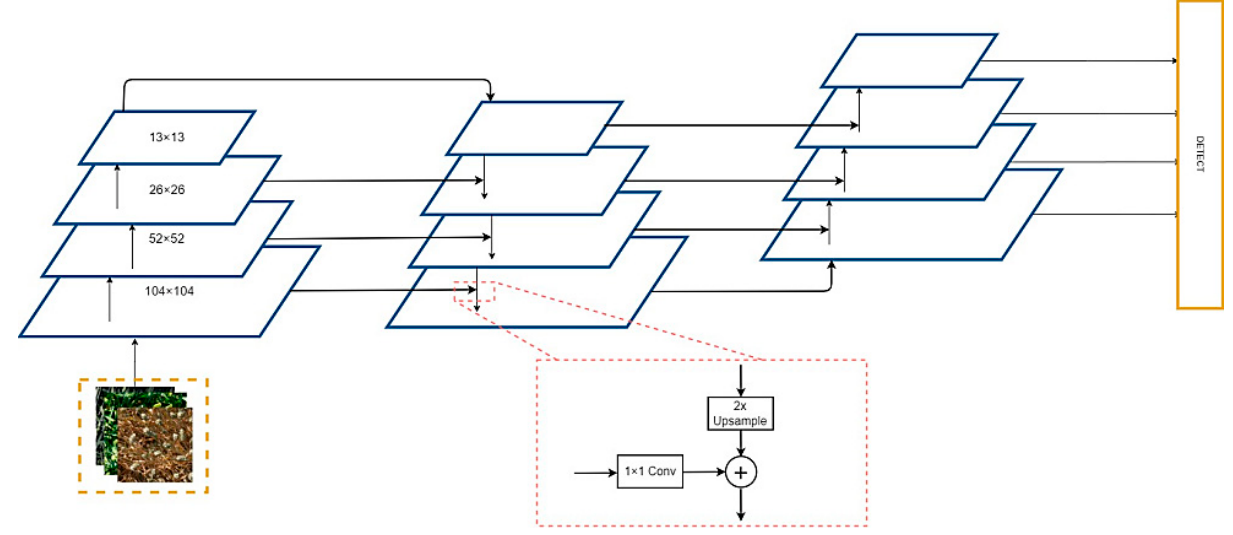
Figure 7. The improved feature fusion network.